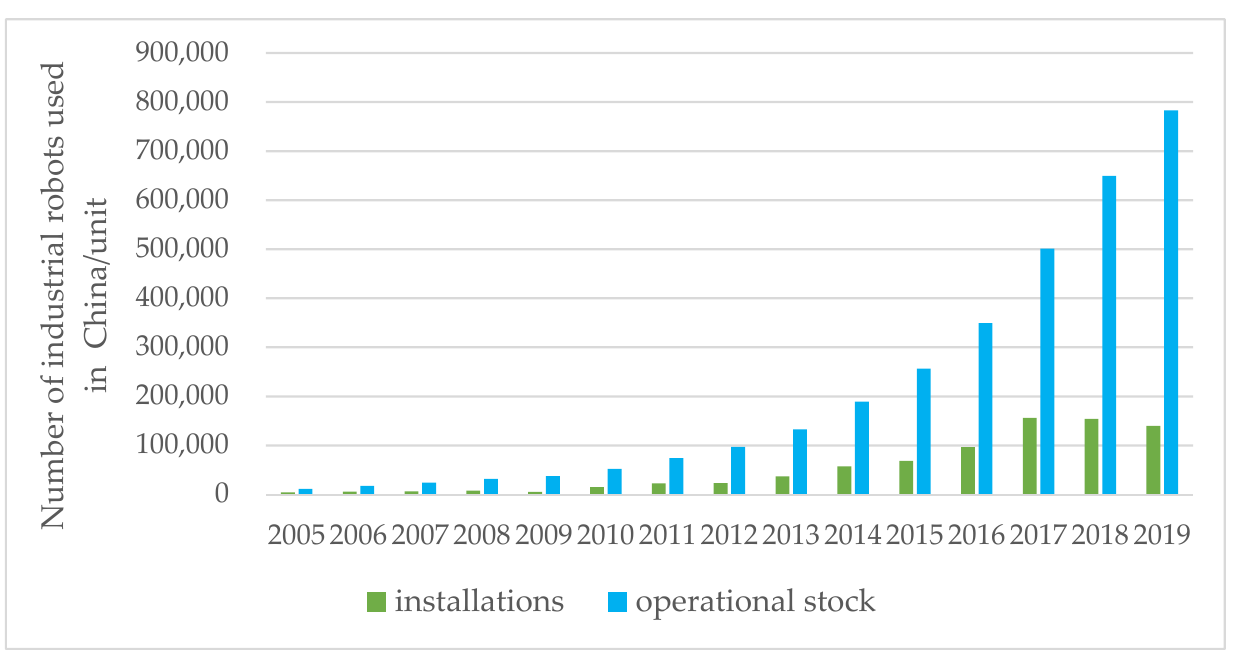
Figure 1. Installation and use of industrial robots in China.